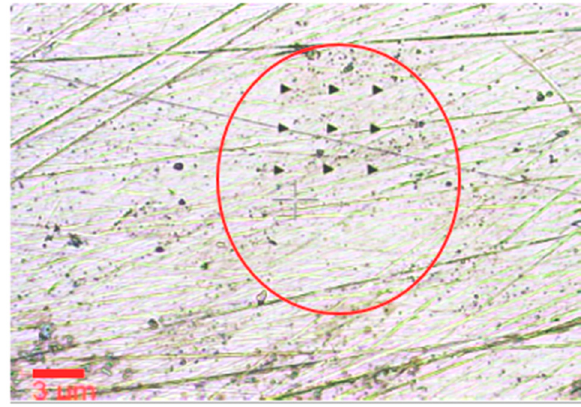
Figure 13. Optical imaging of the layer deposition and nano-identation Map in hardness determination of specimen.